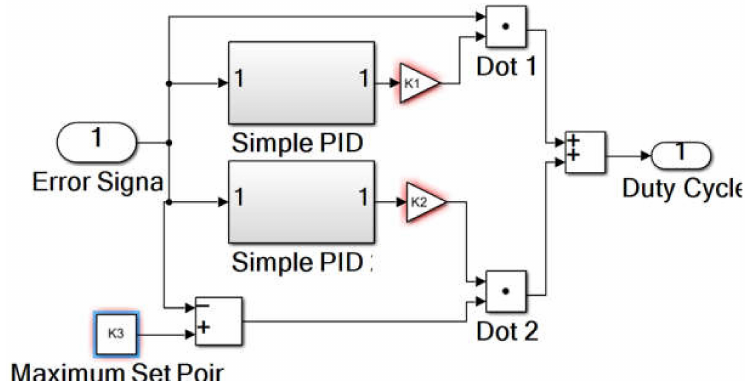
Figure 6. The construction of the SUI-PID.